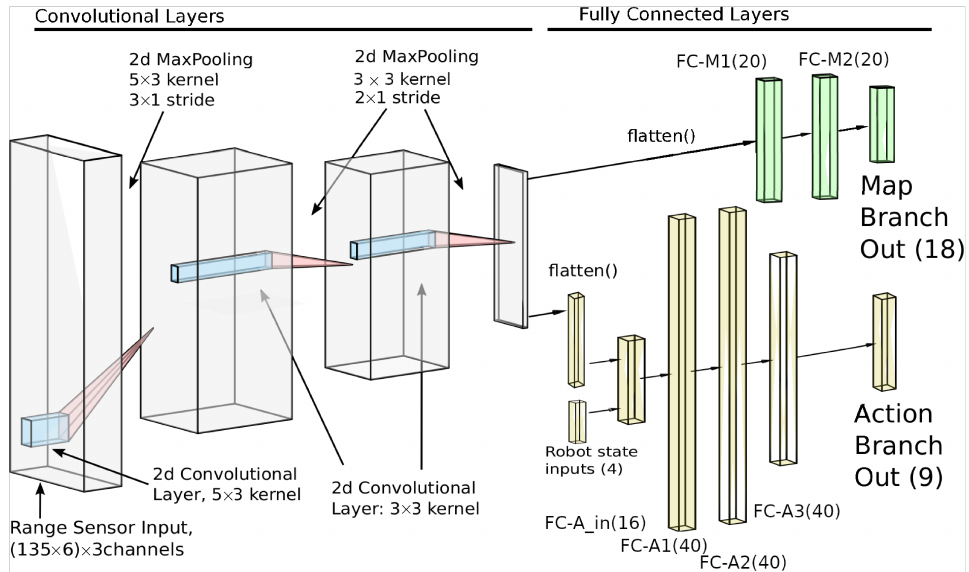
Figure 8. Schematic representation of the NN used in the DQL case Q ( s ) . For policy learning π ( s ) , a SOFTMAX layer is added at the end, while in the case of the state-value function V ( s ) the last layer has a unique